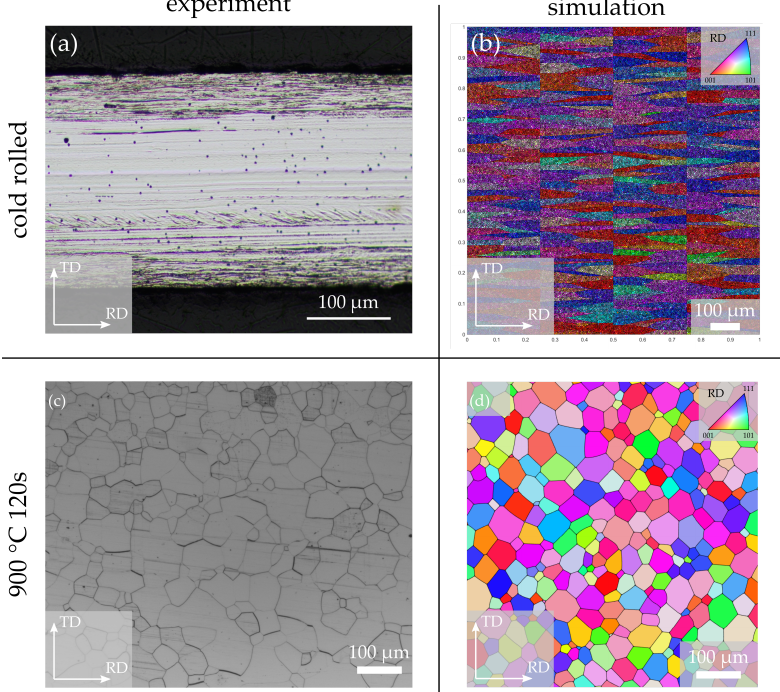
Figure 11. Light microscopy images of ( a ) the cold rolled and ( b ) the sheet annealed at 900°C in comparison to the simulated microstructures ( c ) using the microstructure generator to produce the equivalent to the cold-rolled state and ( d ) the resulting microstructure after simulation of RX and